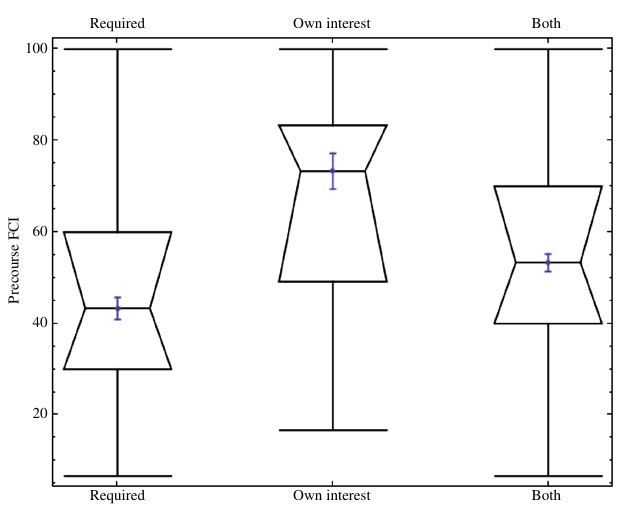
FIG. 3. Boxplots of the precourse FCI scores for different reasons for taking PHY131.